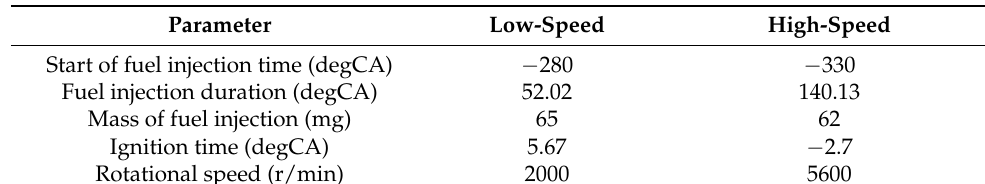
Table 6. Experimental operating parameters.